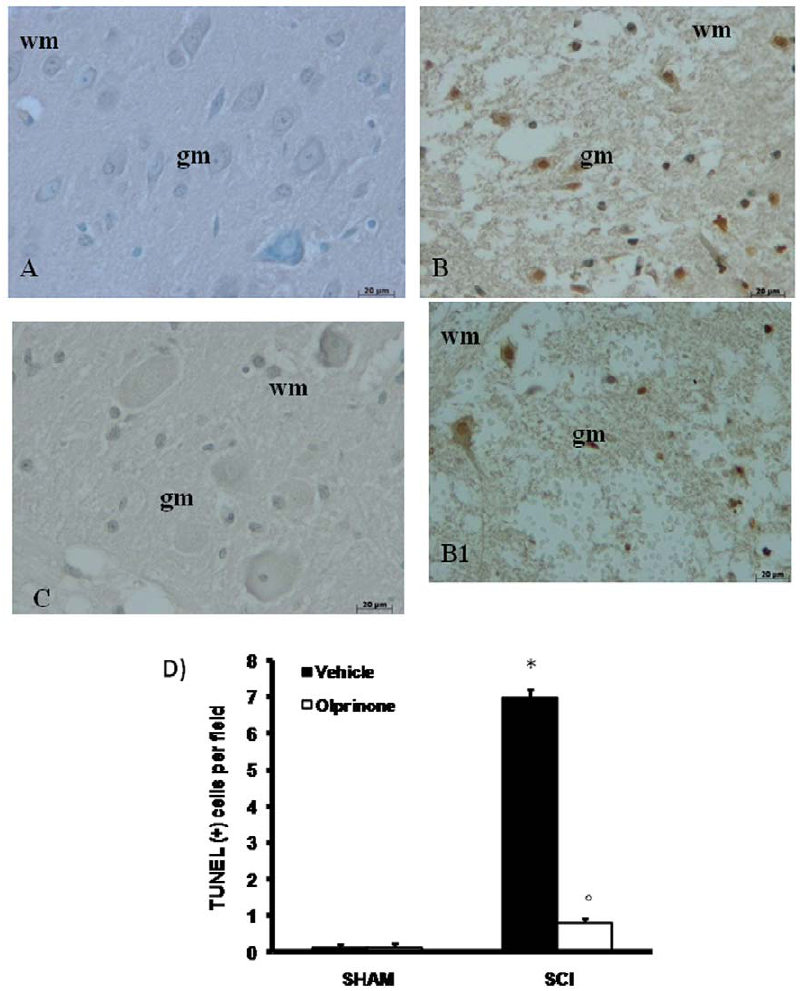
Figure 9. Effects of olprinone on TUNEL-like staining in the perilesional spinal cord tissue and S100 b expression. At 24 h after the trauma, SCI mice demonstrated a marked appearance of dark brown apoptotic cells and intercellular apoptotic fragments ( B and B1 ). In contrast, tissues obtained from mice treated with olprinone (0,2 mg/kg) demonstrated no apoptotic cells or fragments ( C ). The number of TUNEL positive cells/high-power field was counted in 5 to 10 fields for each coded slide ( D ). Figure is representative of at least 3 experiments performed on different experimental days.